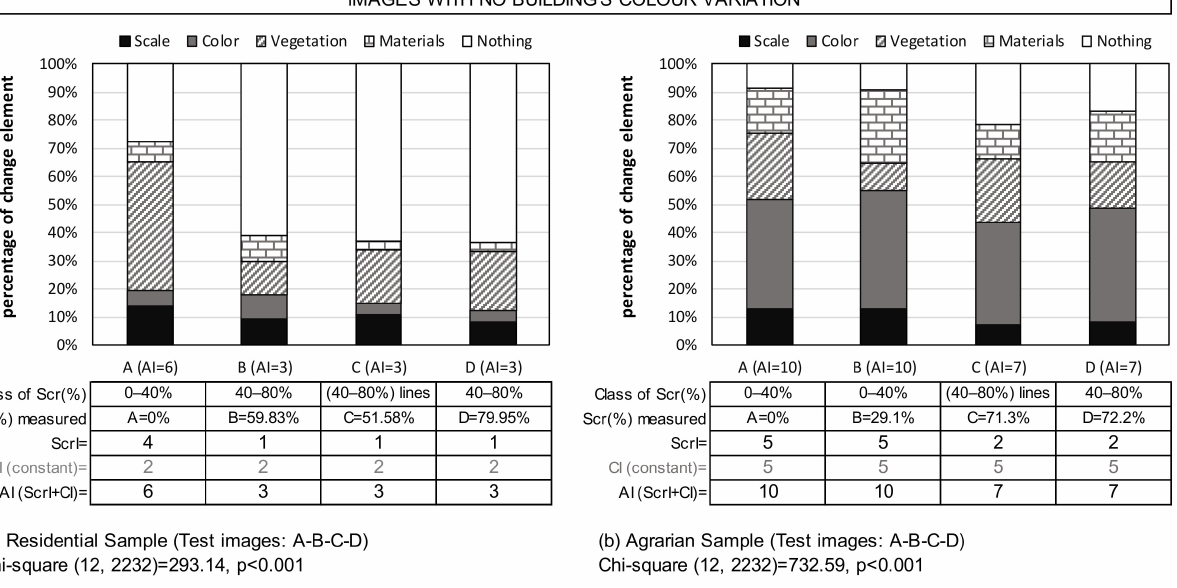
Figure 5. Results of repeated-measures ANOVA to quantify the isolated effect of screening on silhouette lines. ( a ) Rating average for Residential Sample (Test images: A-B-C-D, (Figure 3). ( b ) Rating average for Agrarian Sample (Test images: A-B-C-D, (Figure 4). Different letters in lower case indicate significant differences in RA between compared images (Bonferroni